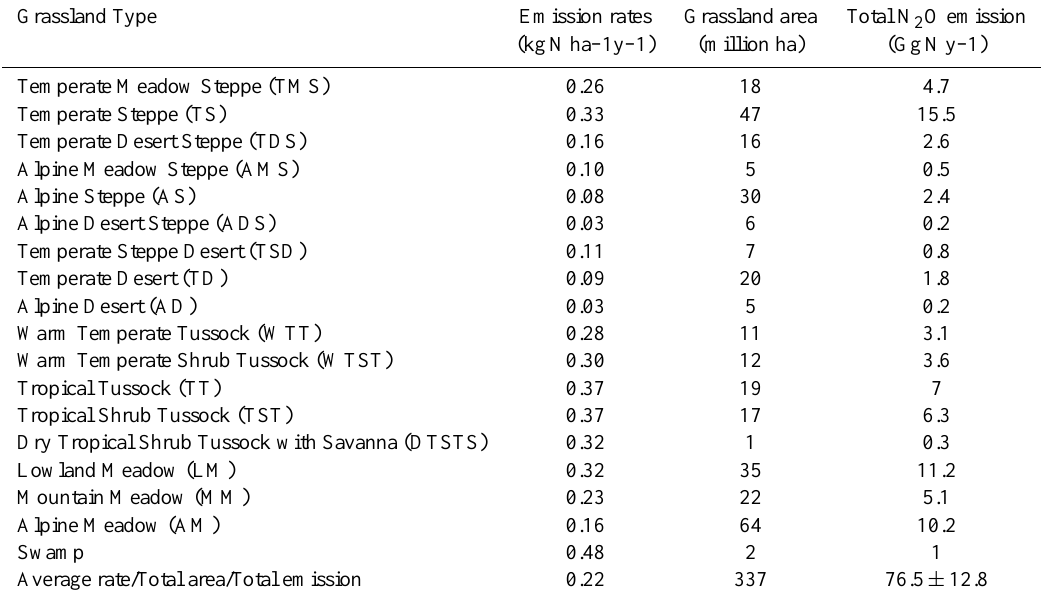
Table 3. Modelled average N 2 O emission rates over eight years for 18 types of grassland in China (kgNha − 1 y − 1 ) , grassland area and total N 2 O emission per year.